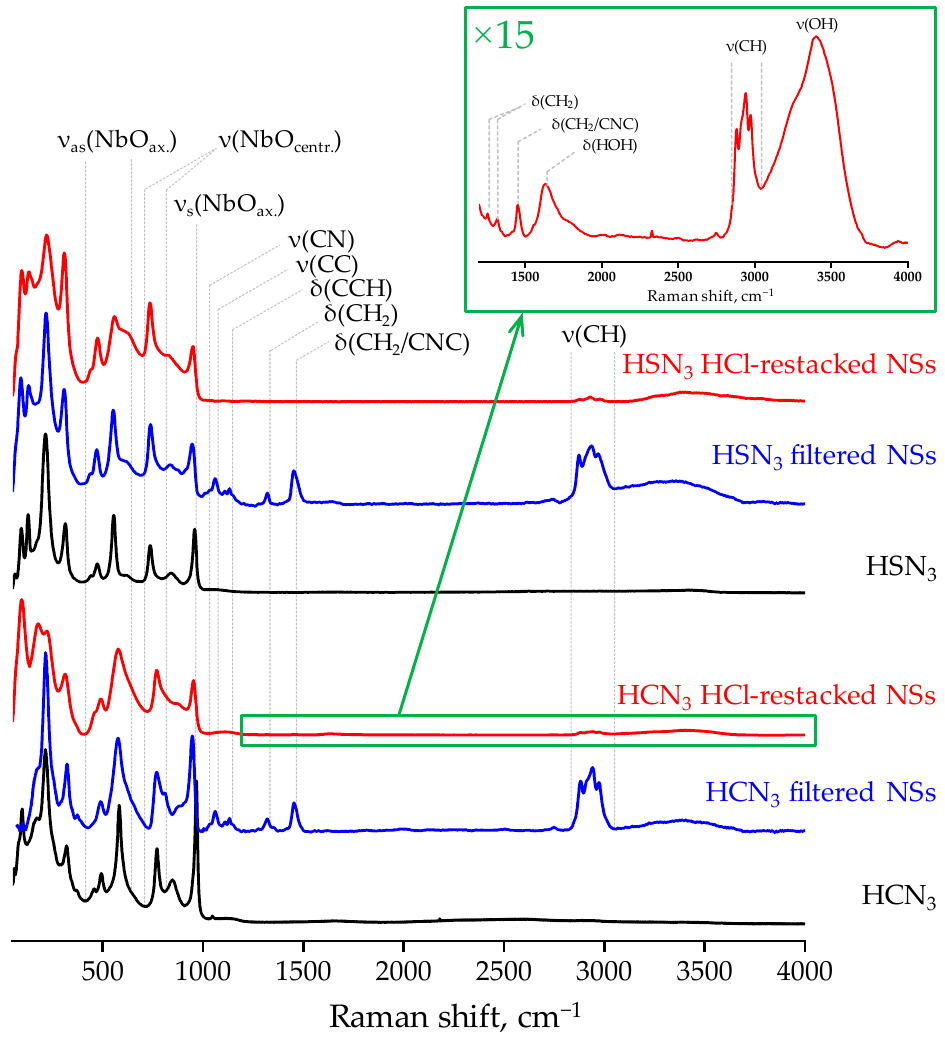
Figure 2. Raman spectra of the protonated niobates and their reassembled nanosheets. Exfoliated and reassembled niobates, with the exception of HSN 3 HCl-restacked NSs, demonstrate lower bandgap energy values than their bulk precursors (Figure 3, Table 1), which allows the final nanosheets to utilize a greater part of light to drive a photocatalytic reaction. Particularly, the absorption edge of HSN 3 filtered NSs approaches very close to the visible spectrum region (E g = 3.14 eV, λ max = 395 nm). However, while HCN 3 HCl- restacked NSs possess even lower bandgap energy than filtered NSs, its value for HSN 3 HCl-restacked NSs is equal to that for the protonated niobate. A specific reason for this difference is yet unclear, however, it may originate from the peculiarities of the nanosheet stacking upon the acid